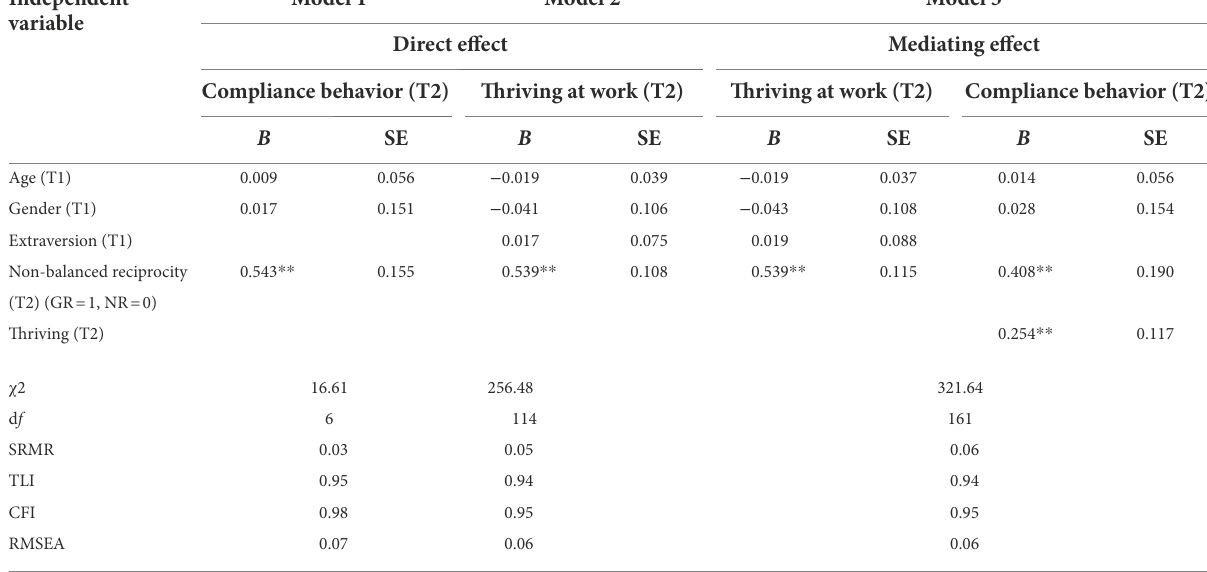
TABLE 3 The direct and mediating effect analyses.